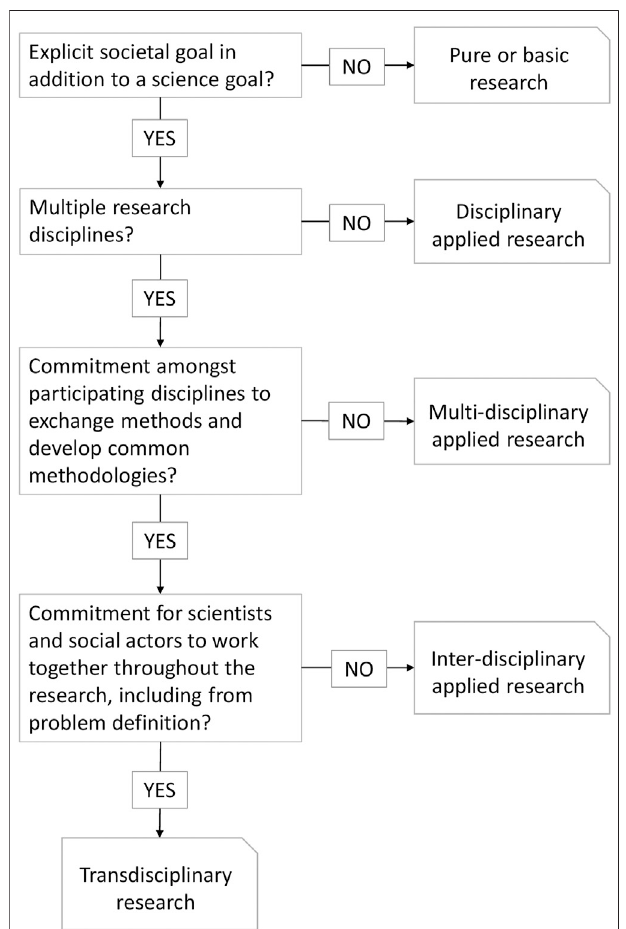
FIGURE 1 | Decision tree comparing TDR with other research